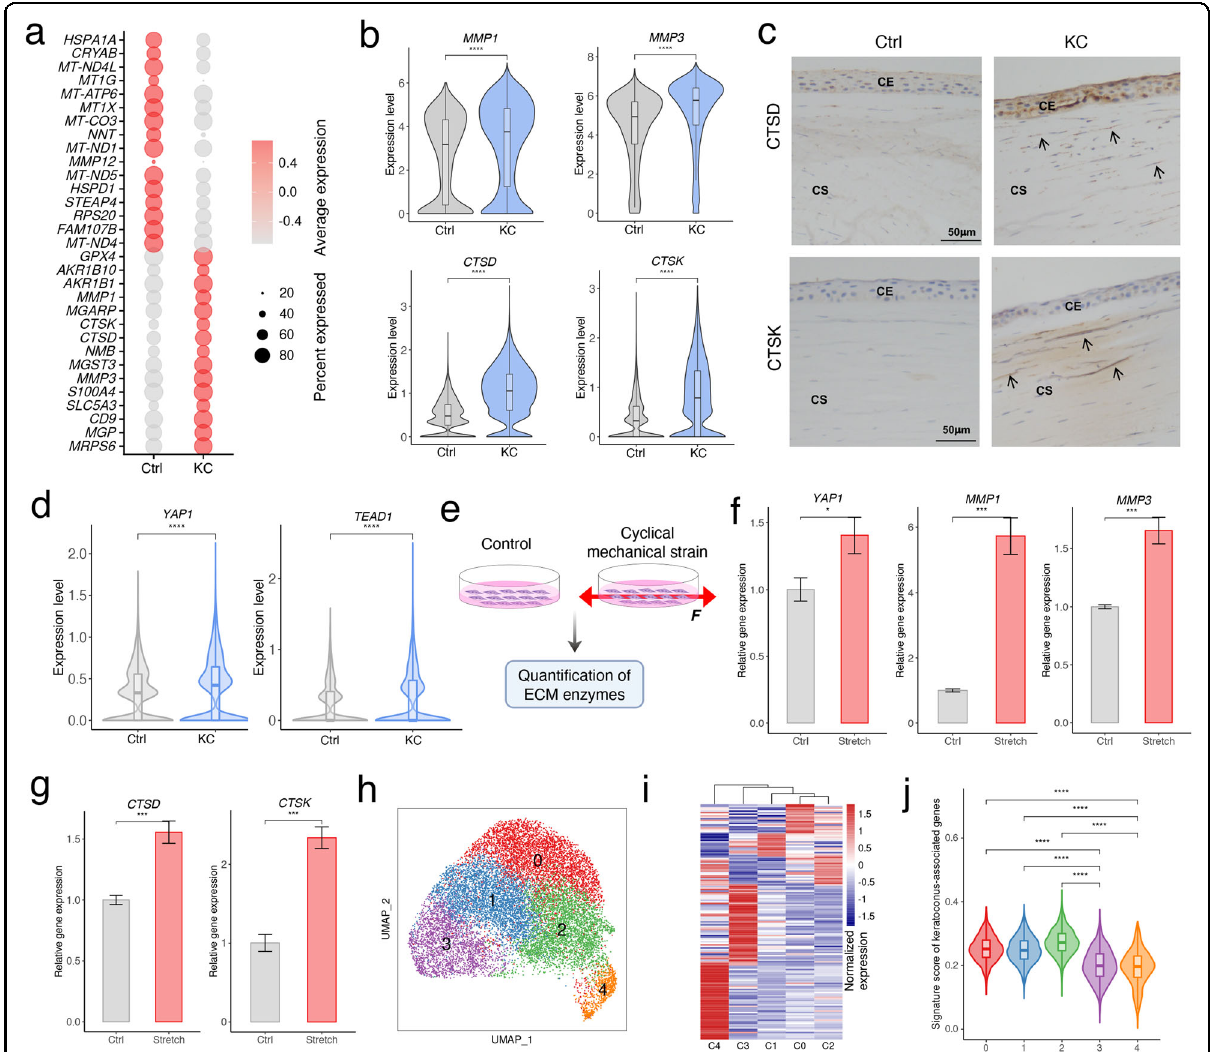
Fig. 3 Transcriptional alterations and heterogeneous analysis of CSCs in KC and Ctrl samples. a Dot plot showing top 15 up- and down- regulated genes in keratoconus CSCs than that in Ctrl samples. b Expression changes of MMP1 , MMP3 , CTSD and CTSK in keratoconus CSCs. c Immunohistochemical analysis showing the elevated level of CTSD and CTSK in keratoconus stroma. d Expression changes of YAP1 and TEAD1 in keratoconus CSCs. **** P < 0.0001 (two-sided Wilcoxon rank-sum test). e Schematic diagram of cyclical mechanical experiments on cell lines. The mechanical stretch exerted on cells was indicated by red arrow. f Expression of YAP1 , MMP1 and MMP3 in HTK cells quanti fi ed by RT-qPCR. * P < 0.05, *** P < 0.001 (Student ’ s t -test). g Quanti fi cation of CTSD and CTSK in HTK cells by RT-qPCR. *** P < 0.001 (Student ’ s t -test). h UMAP clustering for corneal stromal cells colored by different subtypes. i Heatmap of expression signals of top speci fi cally expressed gene in each subtype of CSCs. The value for each gene is the row-scaled Z score. j Gene scoring analysis across CSC subtypes using keratoconus-associated genes. **** P < 0.0001 (two-sided Wilcoxon rank-sum